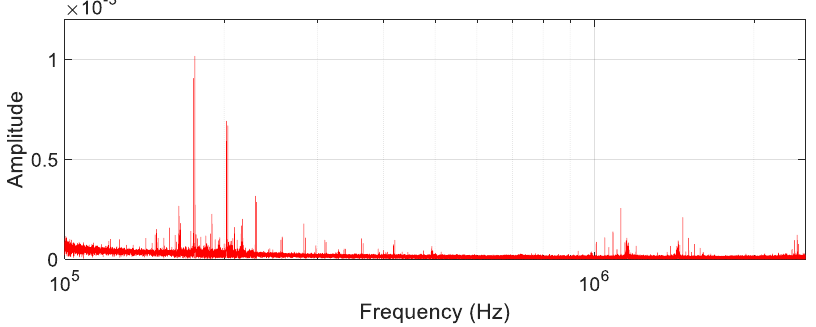
Figure 23. PDs in frequency domain.